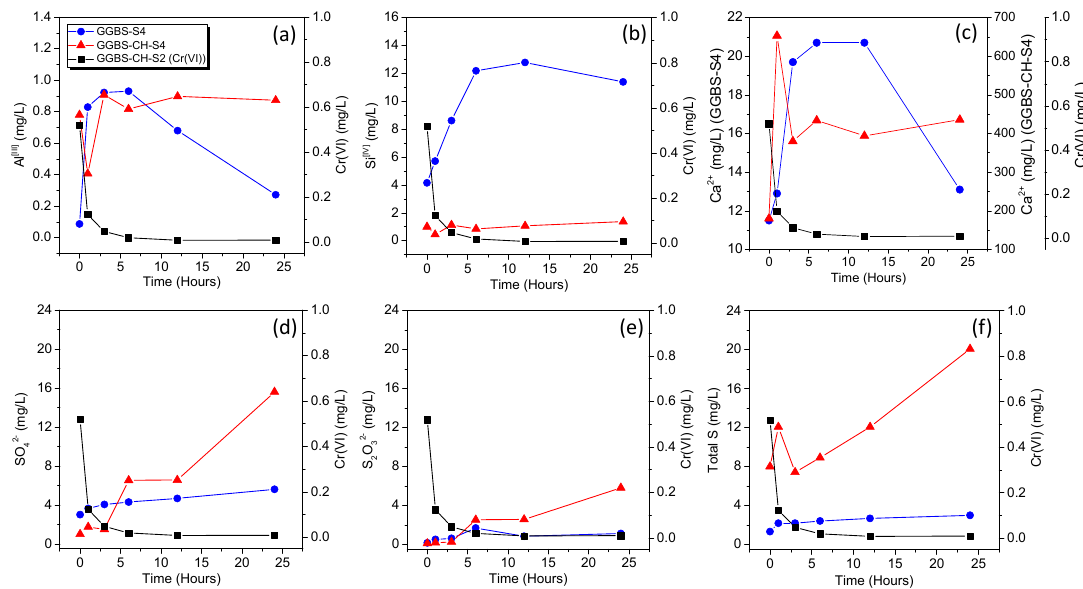
Figure 3. Time profiles for the ion dissolution from GGBS in distilled water (GGBS-S4) and GGBS in Ca(OH) 2 solutions (GGBS-CH-S4) for 0 to 24 h. The Cr(VI) concentration in the GGBS-CH-S2 solution (Figure 2) is presented in the same plot. The maximum value of the y-axis was adjusted to the concentration value of each ion. ( a ) Al [III] ; ( b ) Si [IV] ; ( c ) Ca 2+ ; ( d ) S 2 O 32 − ; ( e ) SO 42 − ; and ( f ) total S.